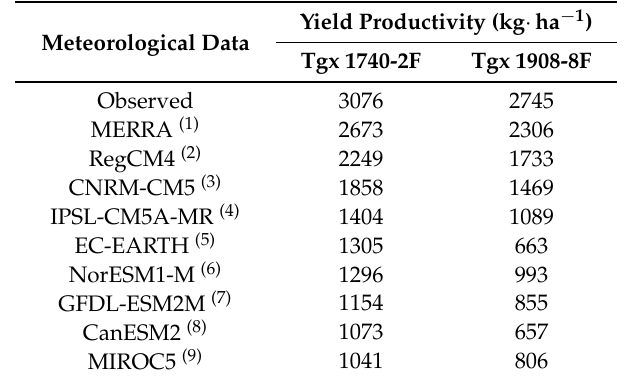
1980–2010 to the CORDEX model, MERRA reanalysis and observed